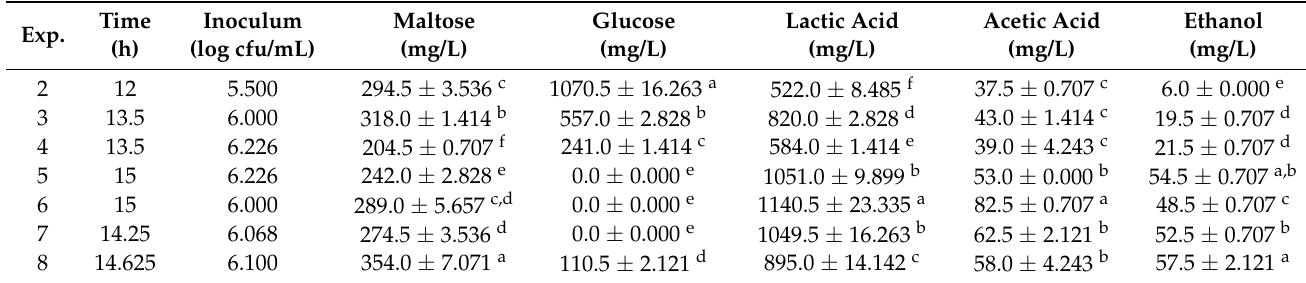
Table 5. Results of sugar, organic acid, and ethanol in the Nelder–Mead simplex process. Exp.